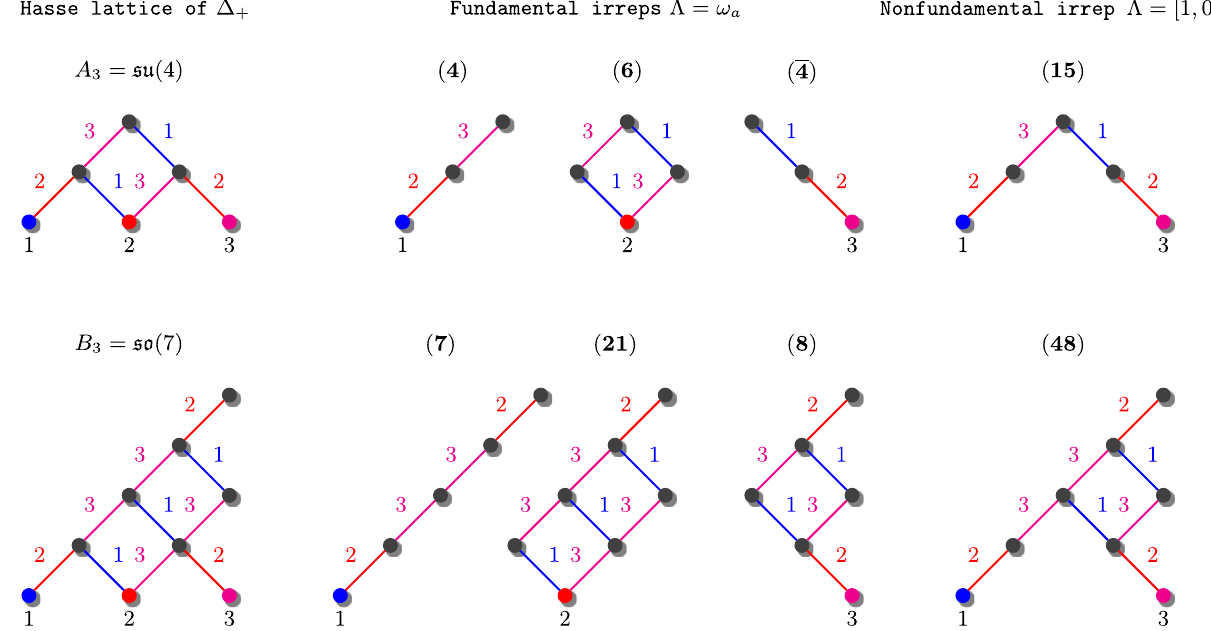
FIG. 5. Left: Hasse diagrams associated with the sublattices Δ of positive roots of g , shown for Lie algebras su ð 4 Þ (top) and so ð 7 Þ þ (bottom) of rank 3. The nodes represent positive roots α ∈ Δ , with the simple ones (at the bottom) marked with different colors. þ Moving upwards along a colored edge amounts to adding a simple root corresponding to that color. Positive roots are separated into l levels, given by the sum of all positive integral coefficients in the expansion of α over the basis of simple roots α . The total number of i Δ positive roots yields the maximal number of Goldstone modes n j ¼ 1 2 dim ð G=T Þ for the full breaking of symmetry G → T . G ¼ j þ Middle: Hasse sublattices pertaining to all the distinct fundamental irreducible representations Λ ¼ ω (i.e., Young diagrams with a a single column), connecting the base node α to the upper node (maximal root). The total number of nodes in a given sublattice equals the a number of distinct branches of magnon excitations (Goldstone bosons). Right: Hasse sublattices for nonfundamental on-site representations (shown for Λ ¼ ½ 1 ; 0 ; 1 (cid:2) ) obtained by superimposition of the fundamental sublattices, each belonging to a single nonvanishing Dynkin